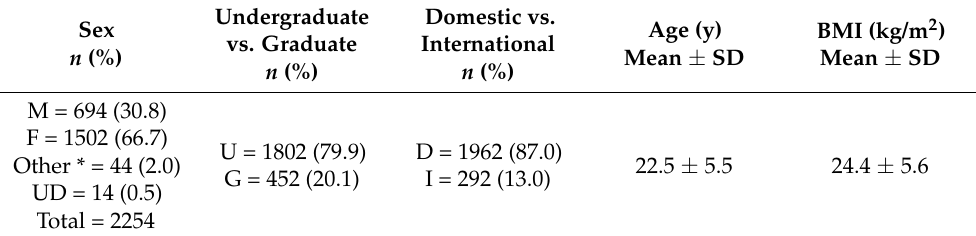
Table 1. Demographic and biological